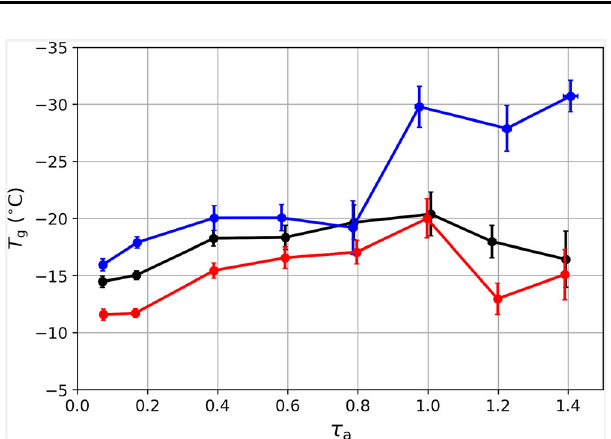
Fig. 1 Glaciation temperature ( T g ) in Amazonian convective clouds, from 2000 to 2014, as a function of the columnar aerosol optical depth ( τ a ), according to classes of atmospheric preconditioning. Red, black, and blue coloring correspond to lower, mid, and upper tertiles, respectively, in the distribution of q 225 , a proxy for the convective preconditioning effect. Aerosol data was obtained from daily averages of level 2.0 AERONET 38 measurements at 5 sites in the Amazon Basin. T g was inferred from GOES satellite imagery acquired in 100 x 100 km boxes around the AERONET sites between 17:00 and 18:00 UTC (13:00-14:00 LT). Error bars correspond to the standard error of the mean. q 225 was obtained from daily 1° gridded ECMWF Era-Interim reanalysis data 39 at 18:00